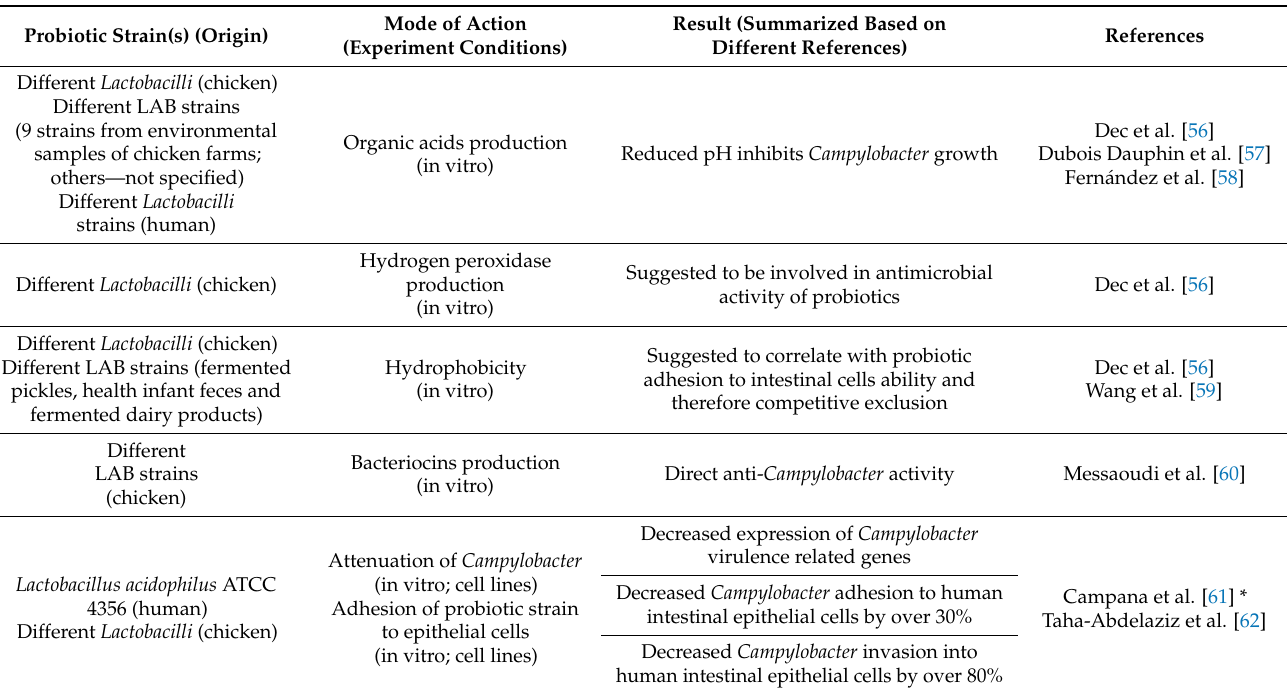
Table 1. Potential mechanisms of anti- Campylobacter activity of probiotics, established based on selected in vitro and in vivo